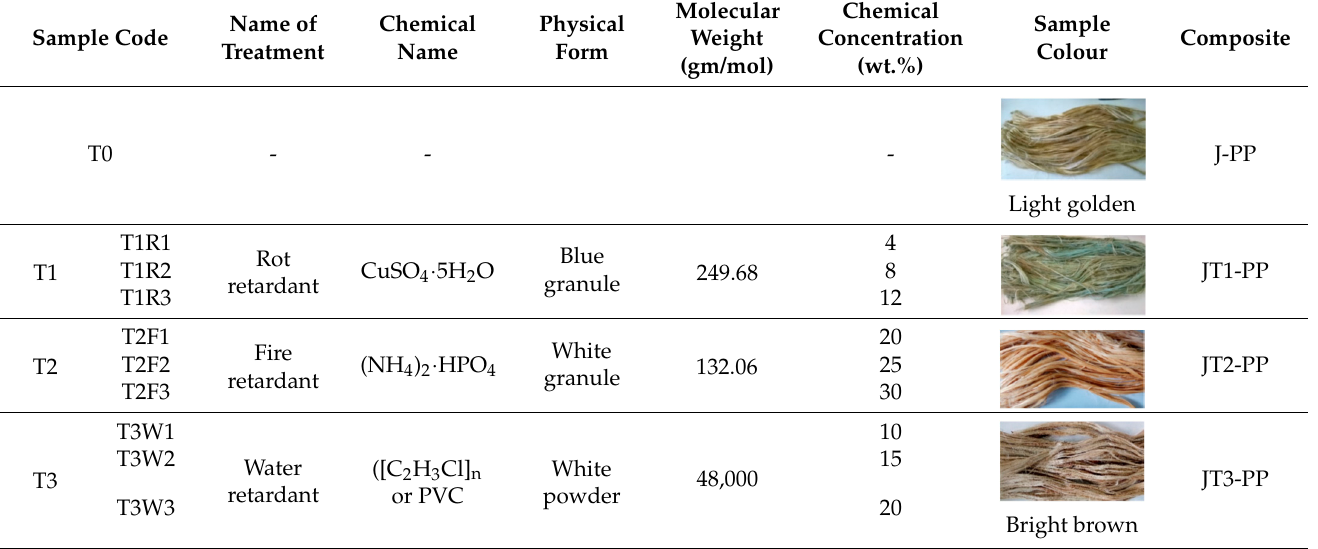
Table 1. Summary of jute and fiber-reinforced composite samples with different chemical treatments. Sample Code Name of Treat- ment